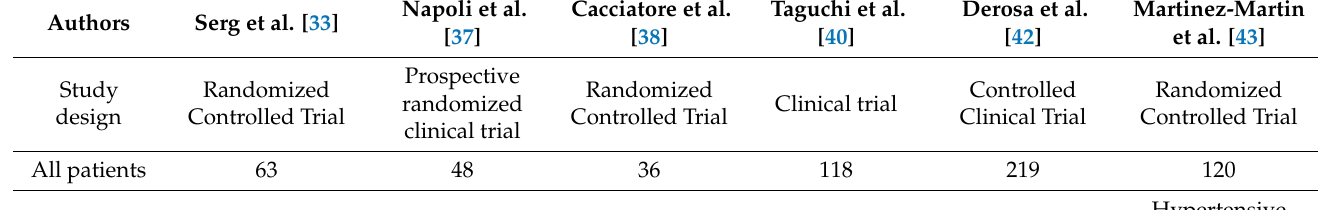
Table 8. Comparison of antioxidant and anti-inflammatory properties of hypotensive